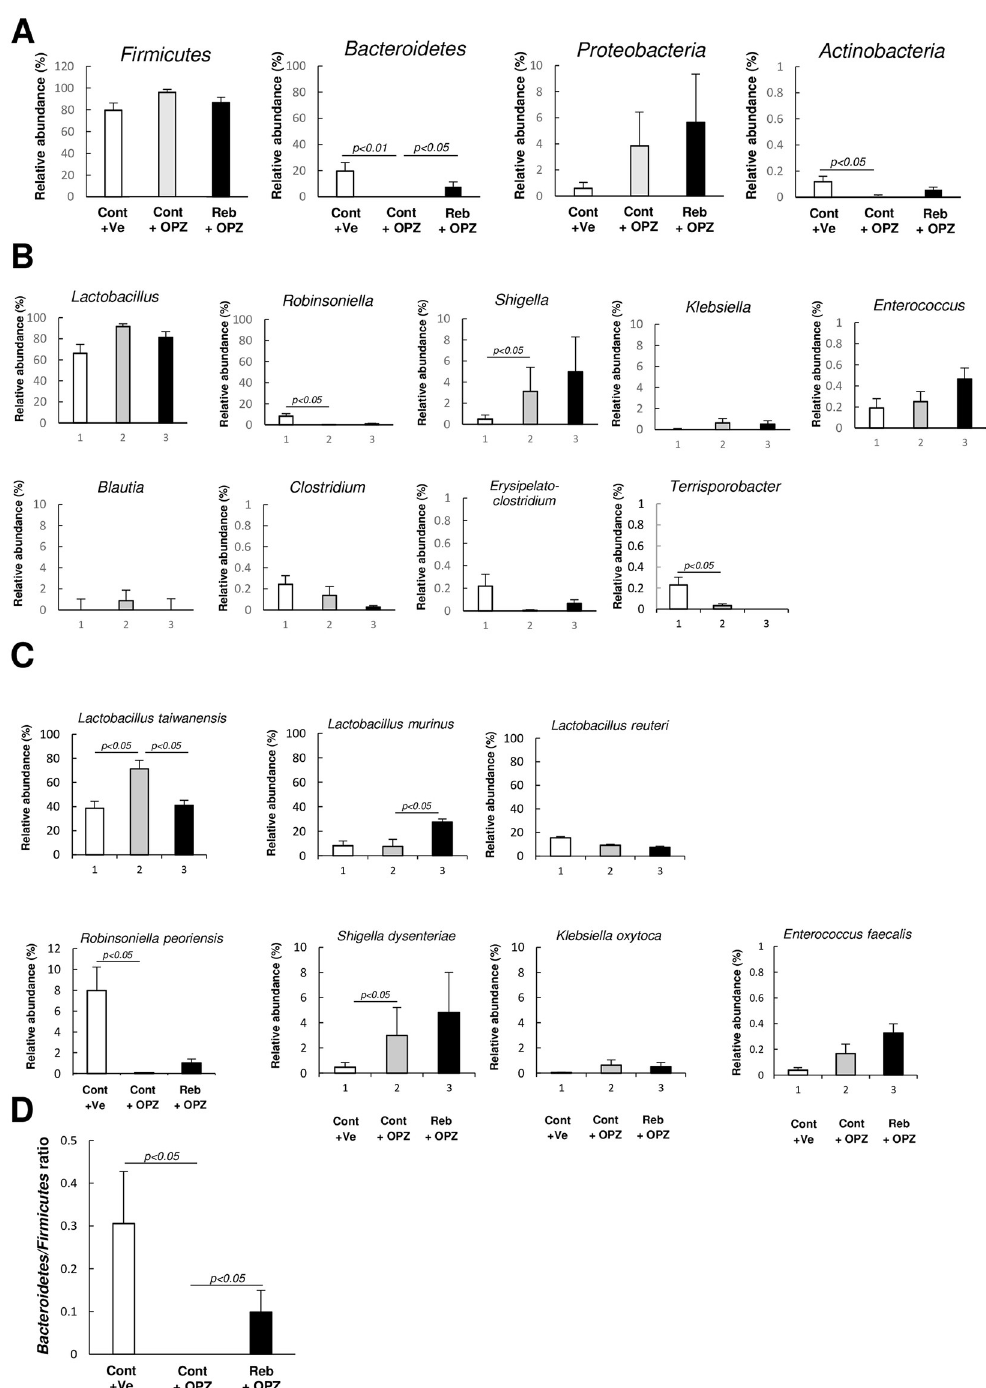
Fig 6. The major bacterial composition of small intestine in microbiota-transplanted mice administered with omeprazole or vehicle at (A) phylum level (B) genus level (C) species level. (D) Bacteroidetes to Firmicutes ratio. Cont + Ve: vehicle- administered group transplanted with control microbiota, Cont + OPZ: omeprazole-administered group transplanted with control microbiota, Reb + OPZ: omeprazole-administered group transplanted with rebamipide-modulatd microbiota. Each column represents the mean ± standard error of the mean (S.E.M.). N = 6–7.